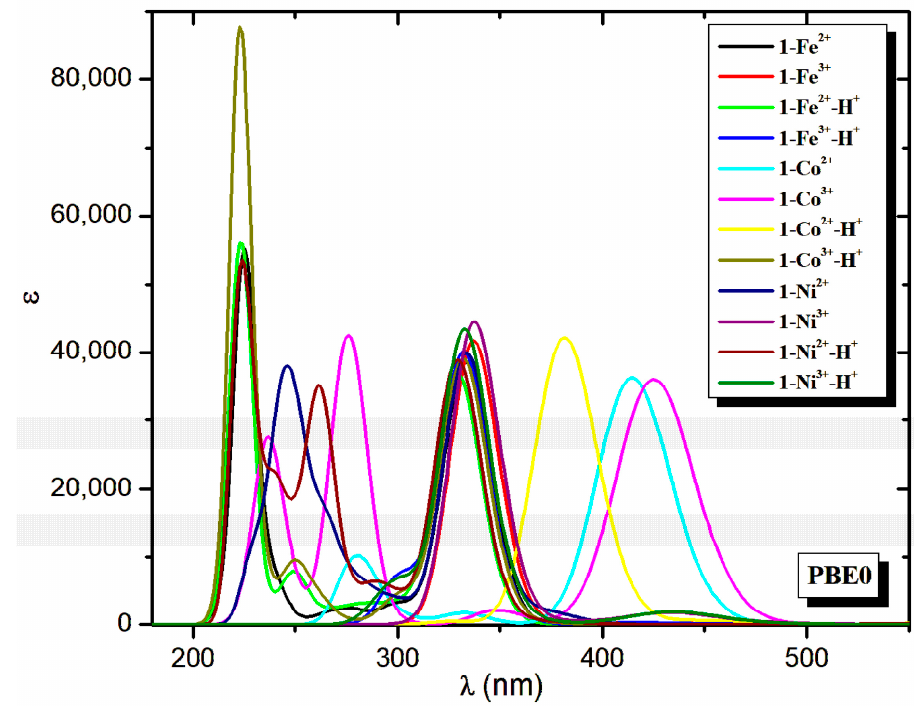
Figure 2. Absorption spectra of the calculated minima at PBE0/6-31G(d,p) in THF solvent.